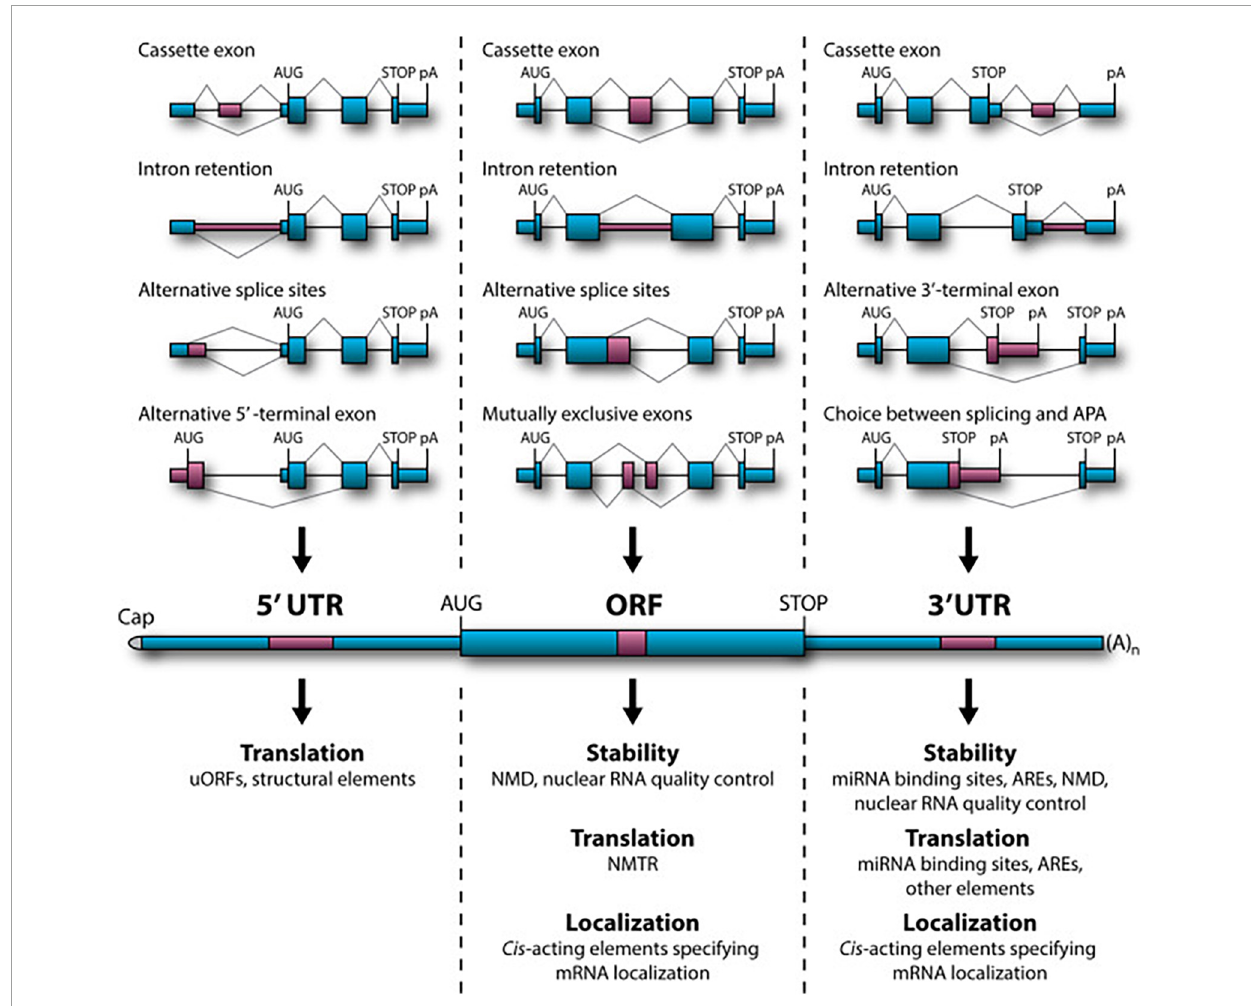
FIGURE1 Role of alternative splicing (AS) in mRNA stability, translational activity and subcellular localization. (Top) Examples of relevant AS topologies; mid: mature mRNA containing 5 (cid:48) and 3 (cid:48) UTRs flanking the protein-coding ORF; (bottom) downstream regulation outcomes of AS events in the corresponding regions. APA, alternative cleavage and polyadenylation; ARE, AU-rich element; NMD, nonsense-mediated decay; NMTR, nonsense-mediated translational repression; uORF, upstream open reading frame (ORF). Figure obtained from Mockenhaupt and Makeyev